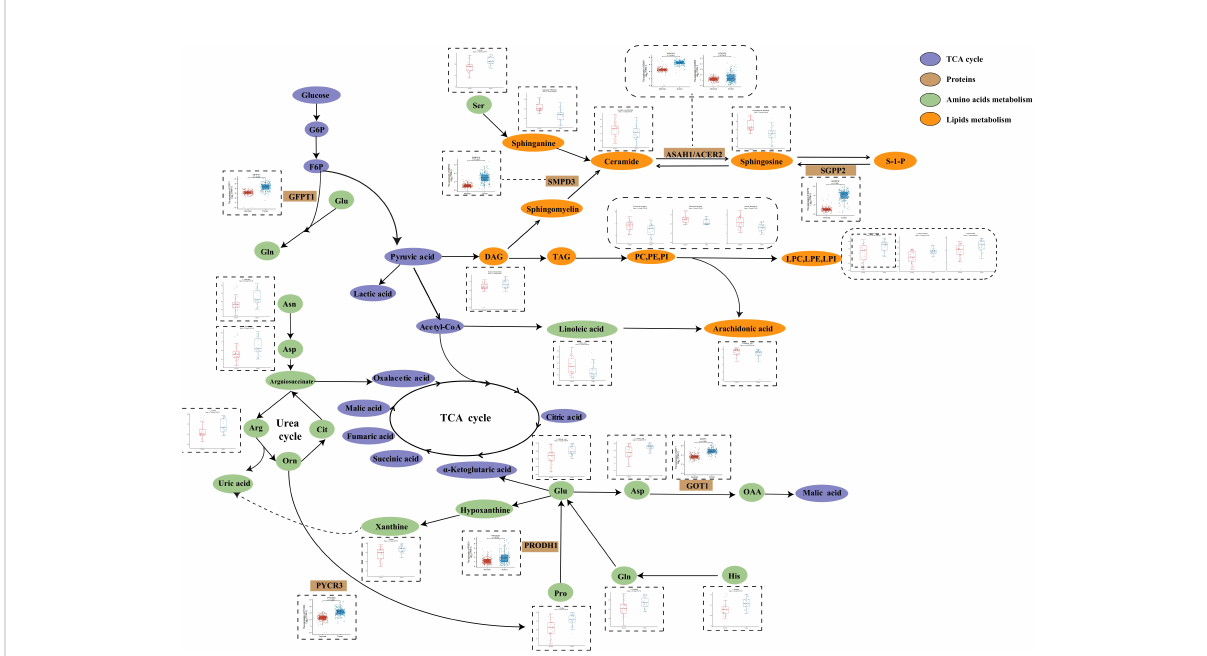
FIGURE 4 Metabolic pathways of some signi fi cantly changed metabolites and related proteins encoded by signi fi cantly changed genes in PC. The blue and red bars represent the corrected responses in the pancreatic tumor tissues and normal pancreatic tissues, respectively; purple, metabolites in TCA cycle. Brown, proteins that catalyze different metabolic changes; green, metabolites involved in amino acids metabolism; orange, metabolites involved in lipids metabolism.